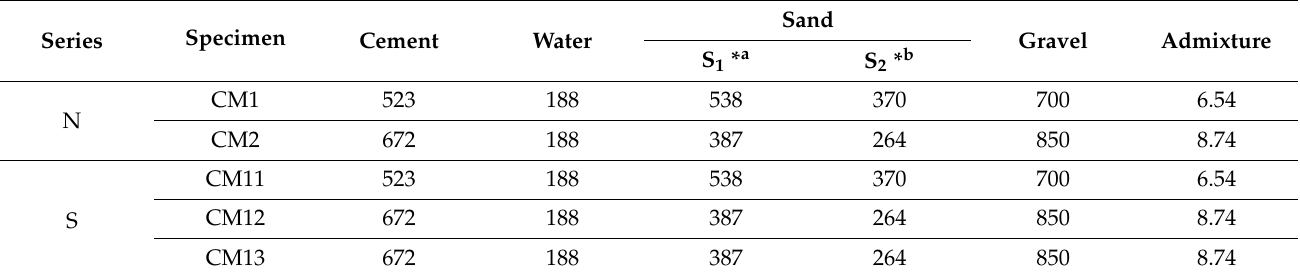
Table 4. Concrete mix proportion (kg/m 3 ).